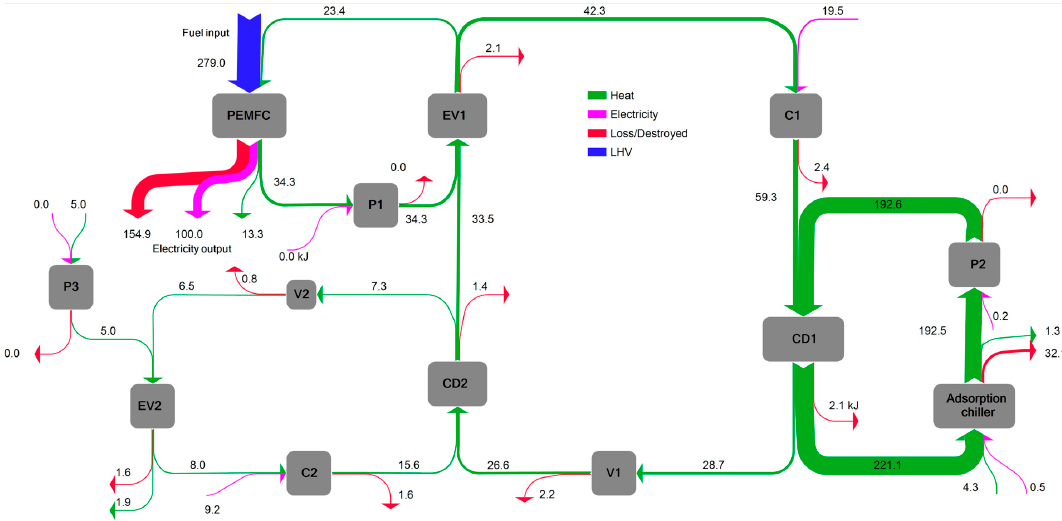
Figure 6. Sankey diagram of exergy flow within the case B system.